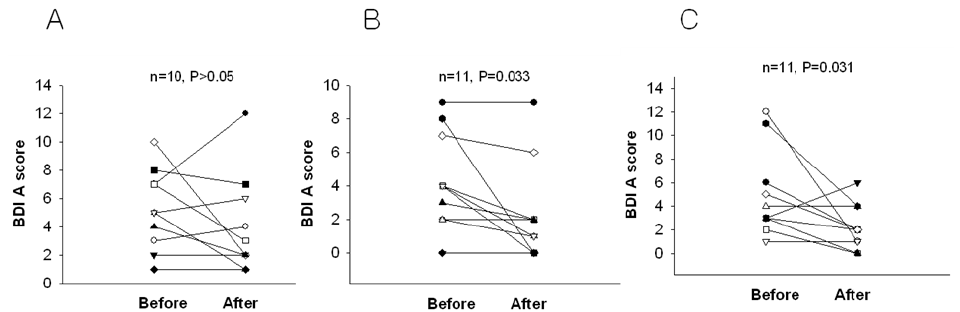
Figure 3. Differences in BDI subscale A mean scores of WNS and placebo groups. ( A ) Placebo group, ( B ) 2.4 g of WNS group, ( C ) 4.8 g of WNS group.